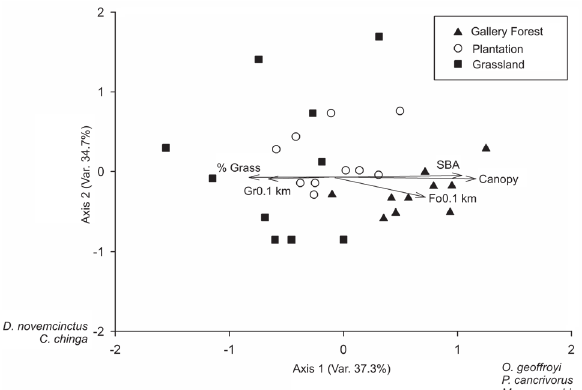
Figure 3. Nonmetric Multidimensional Scaling (NMS) ordination based on mammal species composition. Vectors represent the di- rection and strength of the most important environmental vari- ables. Environmental variables: (%Grass) percentage of grass, (Canopy) canopy cover, (SBA) Stand Basal Area, (Fo0.1Km) per- centage of forest at 0.1 km, (Gr0.lKm) percentage of grassland at 0.1 km. The species outside the ordination plot represent the spe- cies with the highest correlation values with the corresponding axis that influence the ordination.